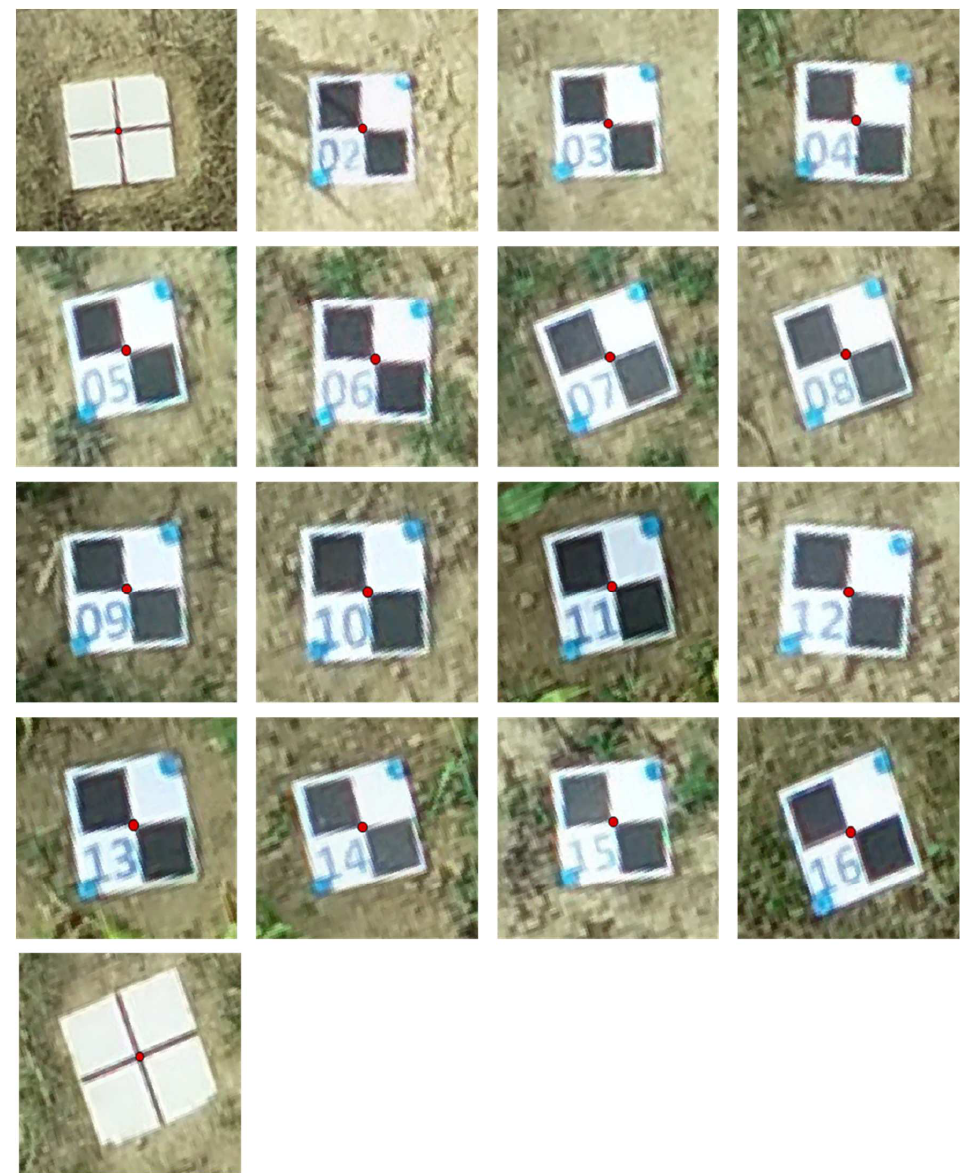
Figure 26. Final ortho-mosaic of R_1 reconstruction, visualized in QGIS software, zoomed in on the 17 GCPs with an overlay of the GCP position measured on the ground using Geo7x DGNSS in tripod mode ( •